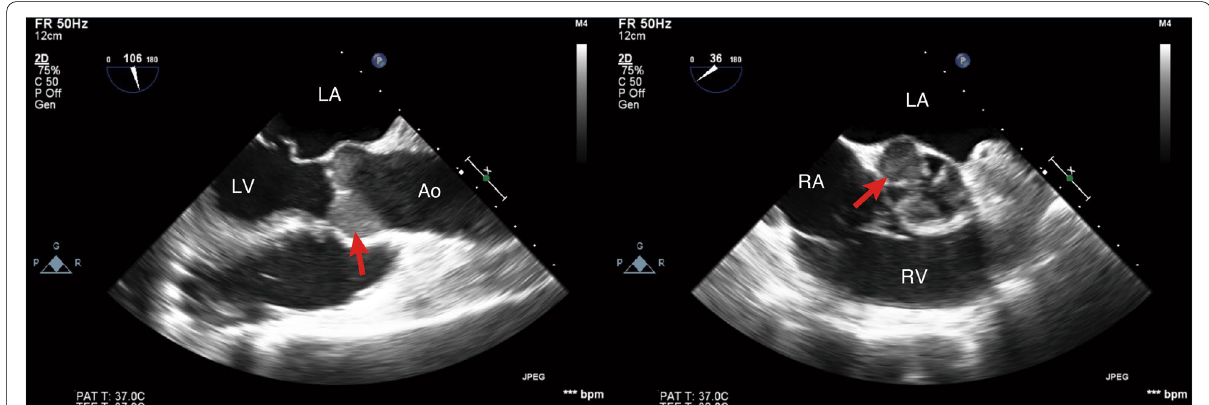
Fig. 1 Mid-esophageal aortic valve long axis (left) and short axis (right) views. Spontaneous echo contrast (arrow) was observed in the sinus of Valsalva after the induction of general anesthesia for the initial mitral valve replacement surgery. Ao, ascending aorta; LA, left atrium; LV, left ventricle; RA, right atrium; RV, right